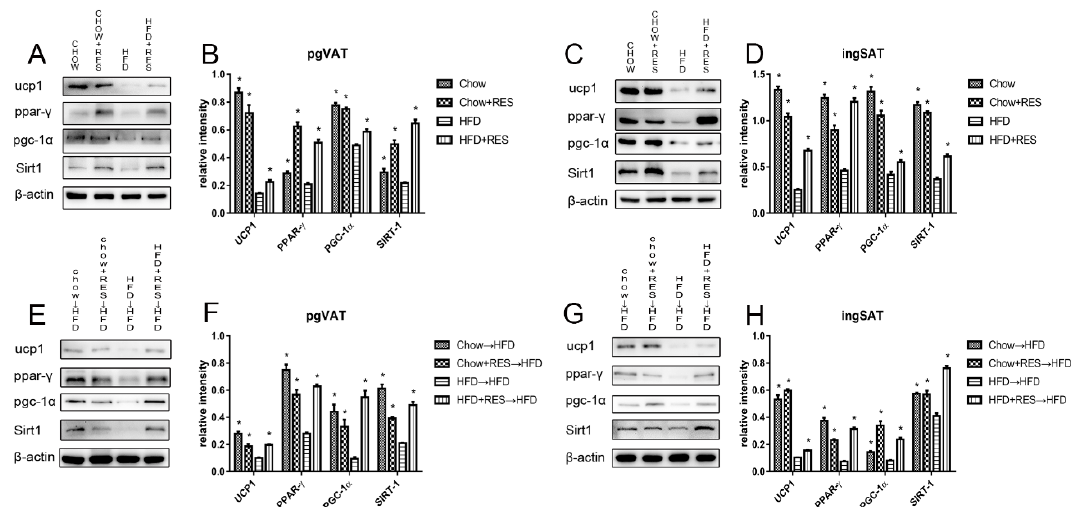
Figure 7. Resveratrol (RES) and fecal transplants from mice administered RES modulated the expression of proteins related to energy expenditure and white adipose tissue (WAT) browning. The effects of RES on the protein expression levels of UCP1, Sirt1, PGC- 1α, UCP1, PPAR - γ and β -actin in ( A ) perigonadal visceral adipose tissue (pgVAT) and ( C ) inguinal adipose tissue (ingSAT) and densitometric analysis of these proteins ( B,D ). Representative adipose immunoblots for Sirt1, UCP1, PGC- 1α, PPAR - γ and β -actin in ( E ) pgVAT and ( G ) ingSAT in recipient mice. Densitometric analysis of these proteins ( F,H ) in each group. * p < 0.05; compared with HFD-CT or HFD HFD.